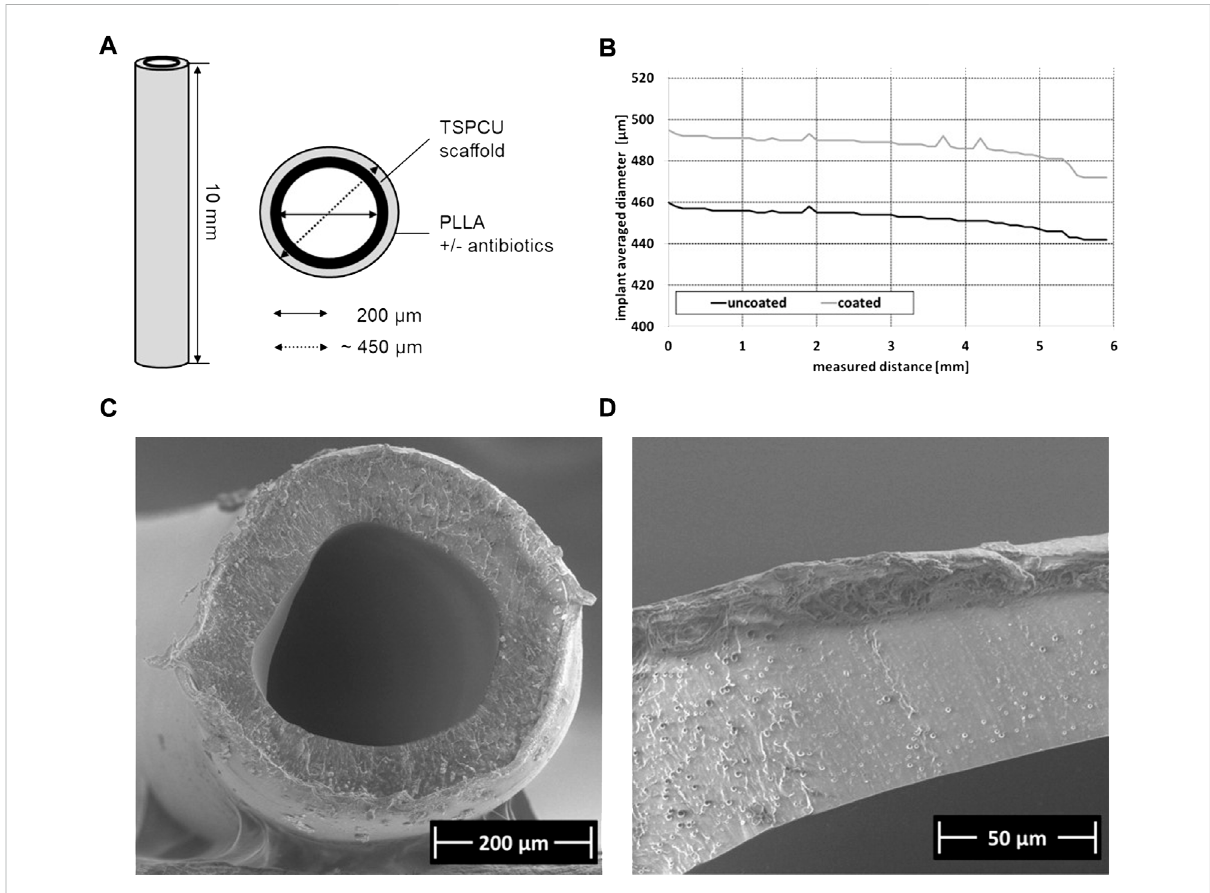
FIGURE 2 Characterization of implants samples (A) Schematic representation of implant design, (B) exemplary measurement of the implant average diameter by biaxial laser scanner, (C) Scanning electron micoscropy (SEM) image of implant cross section with PLLA coating containing rifampicin/ minocycline; magni fi cation ×200, (D) SEM detailed image of the PLLA coating containing rifampicin/minocycline; magni fi cation